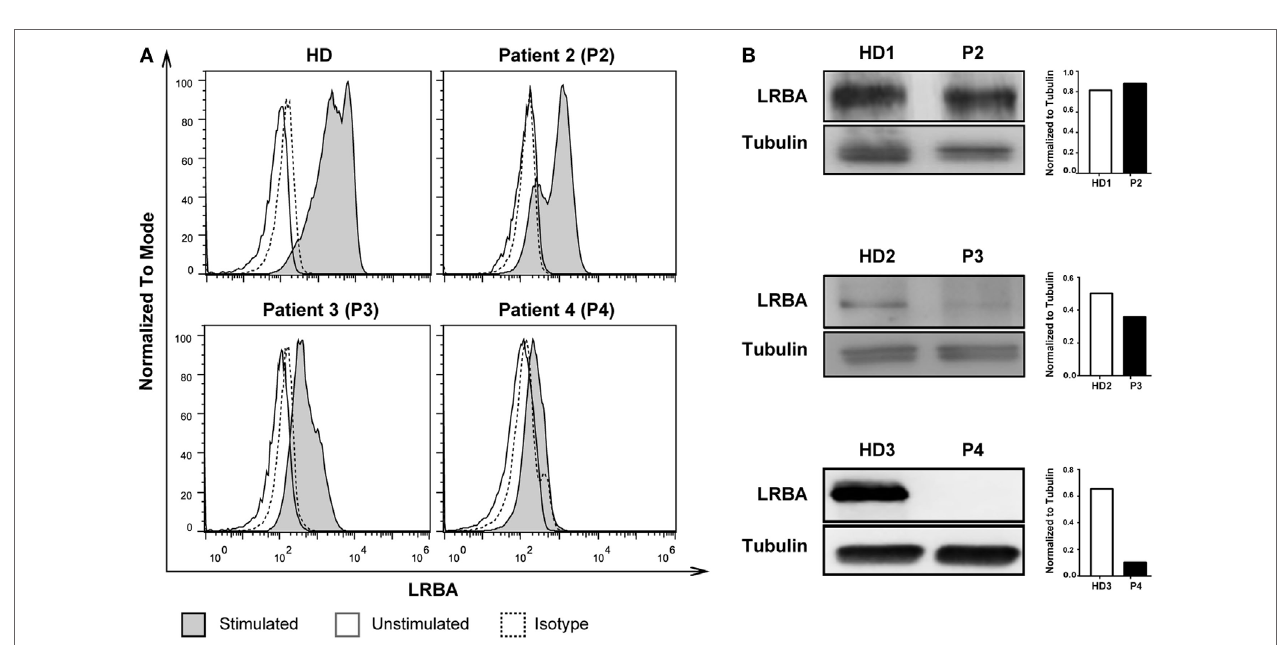
FIGURe 3 | Comparison of LRBA protein expression detection using flow cytometry and western blotting. (A) Flow cytometry analysis of phytohaemagglutinin (PHA)-stimulated peripheral blood mononuclear cells showing normal LRBA expression in a healthy donor (HD) and in patient 2 (P2); reduced LRBA expression in patient 3 (P3); and absence of LRBA expression in patient 4 (P4). (B) Detection of LRBA protein (~319 kDa) and tubulin (~50 kDa) in PHA-stimulated cell lysates from HD, P1, P2, P3, and P4. Respective densitometry quantification graphs of LRBA protein expression normalized against tubulin is shown next to each